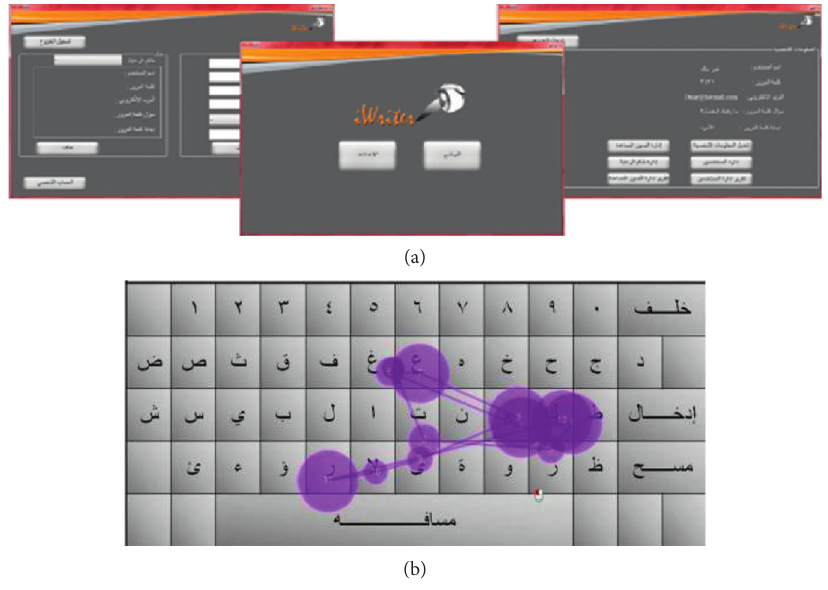
Figure 7: Screenshots of the iWriter software